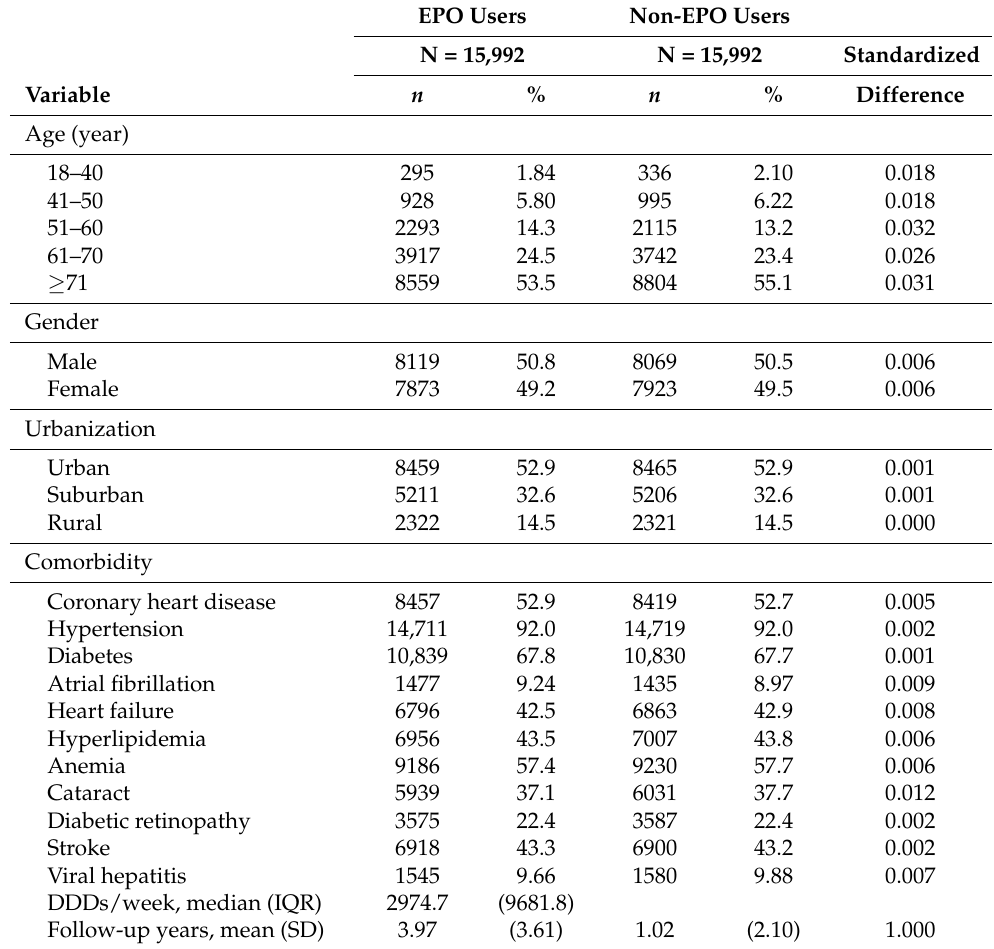
Table 1. Demographic characteristics and comorbidities compared between cohorts with and without erythropoietin treatment in hemodialysis patients in Taiwan.